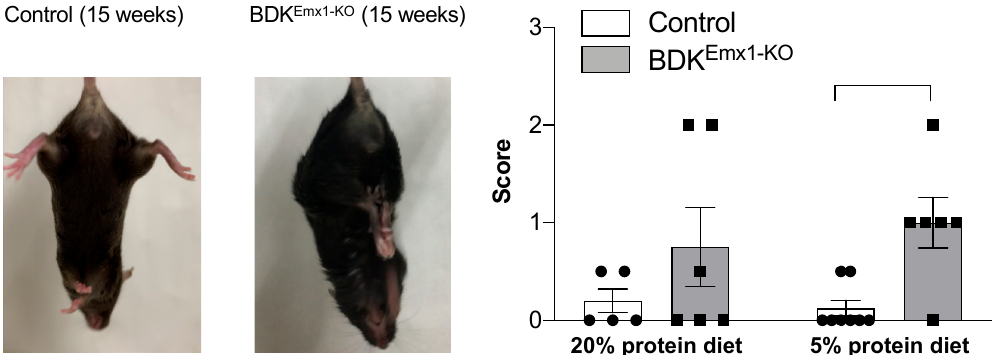
Figure 2. Neurological abnormalities in BDK Emx1-KO mice. Representative hindlimb clasping in control and BDK Emx1-KO mice, and the clasping scores of mice fed a 20% or 5% protein diet are shown. Values represent the mean ± SEM ( n = 5–8 per group). ** p < 0.01. Individual results were indicated as a closed circle (Control mice) and a closed square (BDK Emx1-KO mice). Differences were determined using the